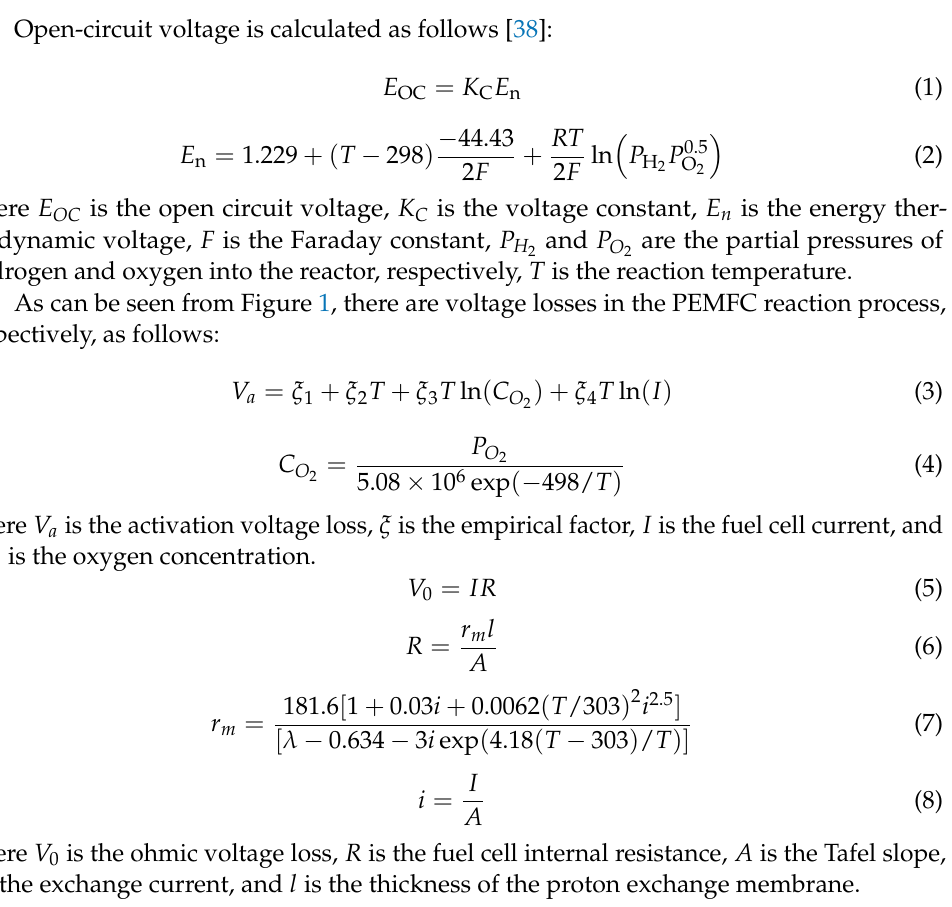
Figure 1. The actual voltage variation curve of the PEMFC.